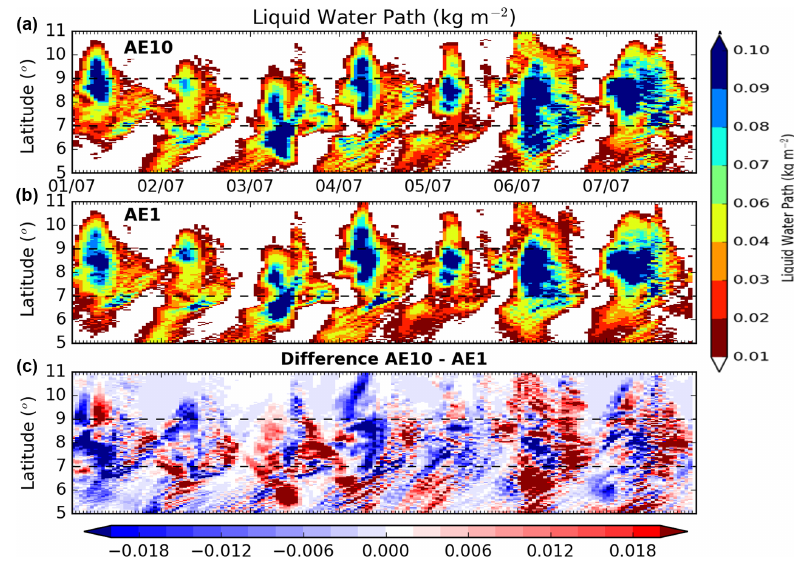
Figure 12. Time–latitude average (Hovmoller) of hourly liquid water path (kgm − 2 ) for the two experiments (a) AE10 and (b) AE1, and (c) the difference (AE10 − AE1), averaged over an area extending from 1 to 4 ◦ E during the period 1–7 July 2016.